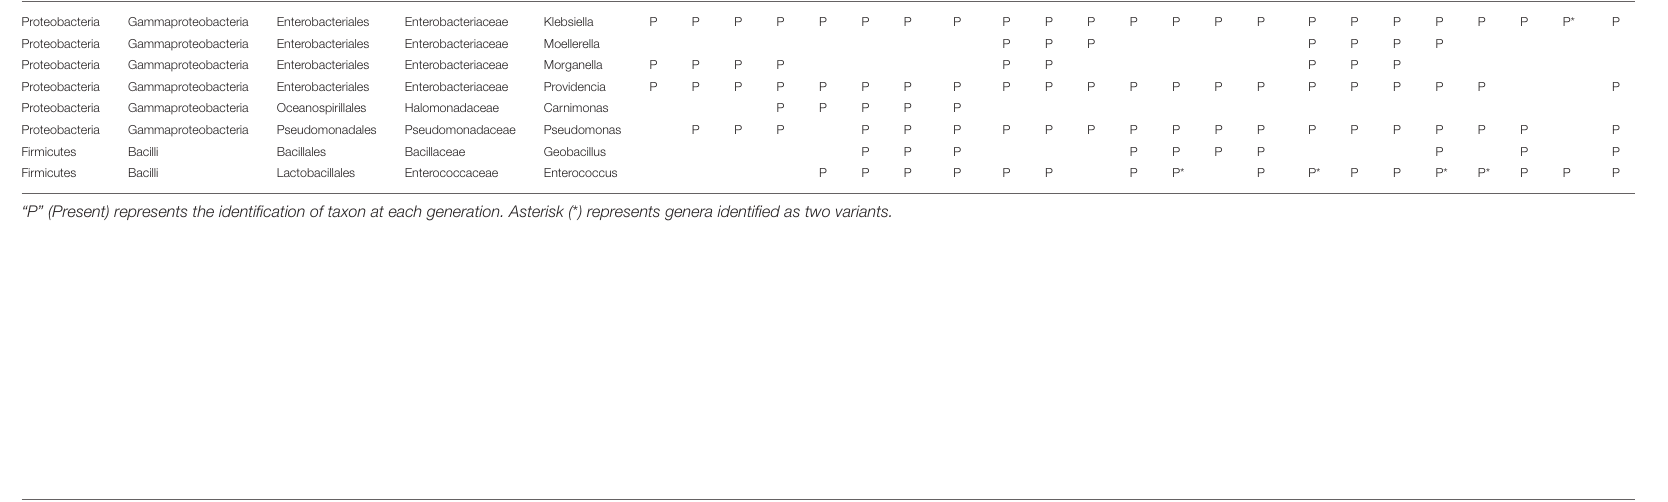
TABLE 2 | Core bacterial taxa determined at each generation of laboratory adaptation of wild C. capitata at 75%